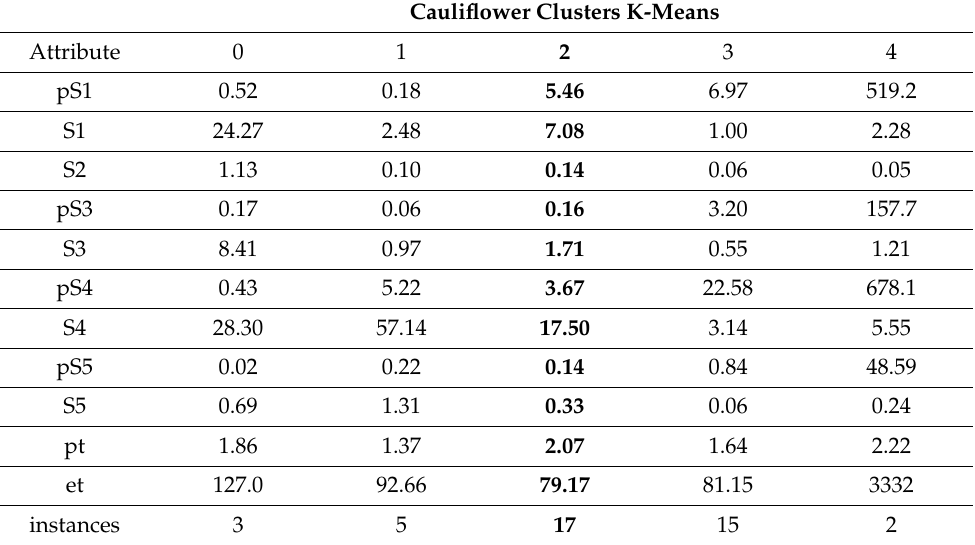
Table 9. K-means clusterization of cauliflower production. The units for the i -th stage (pS1, S1, etc.) are in kWh/ton for pt and in ton/h for et in kWh/h.